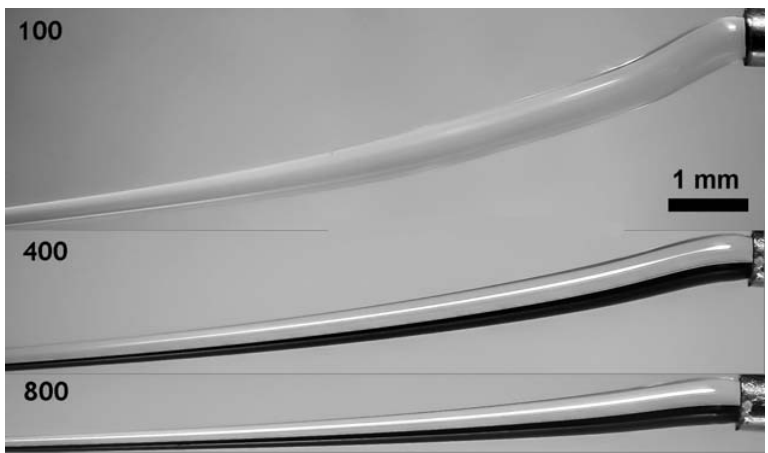
Figure 10. Extension of jets in PAN solution spinning at different rates (indicated in photos).